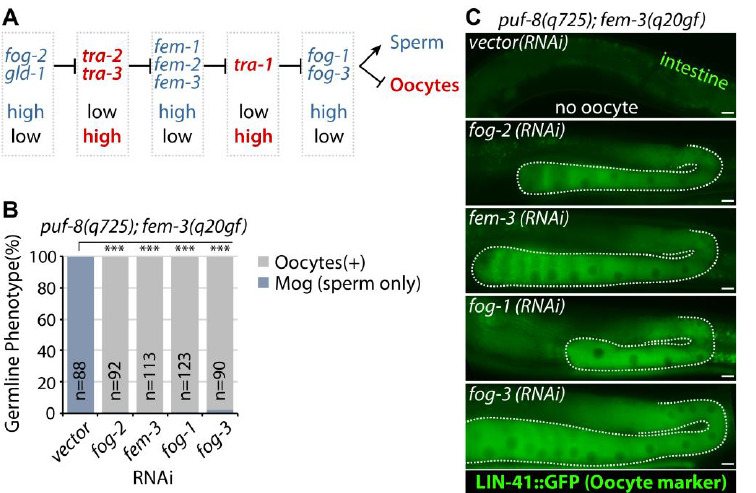
Figure 3. Epistatic analysis. ( A ) A simplified version of the germline sex determination pathway. Red genes promote oocyte fate, and blue genes promote sperm fate. ( B ) Depletion of sperm-promoting genes by RNAi rescues puf-8(q725); fem-3(q20gf) Mog sterility. ( C ) The expression of LIN-41::GFP (oocyte marker). Scale bars are 10 µ m. All experiments were performed in triplicate. The statis- tical significance was assessed by Student’s t-test without corrections for multiple